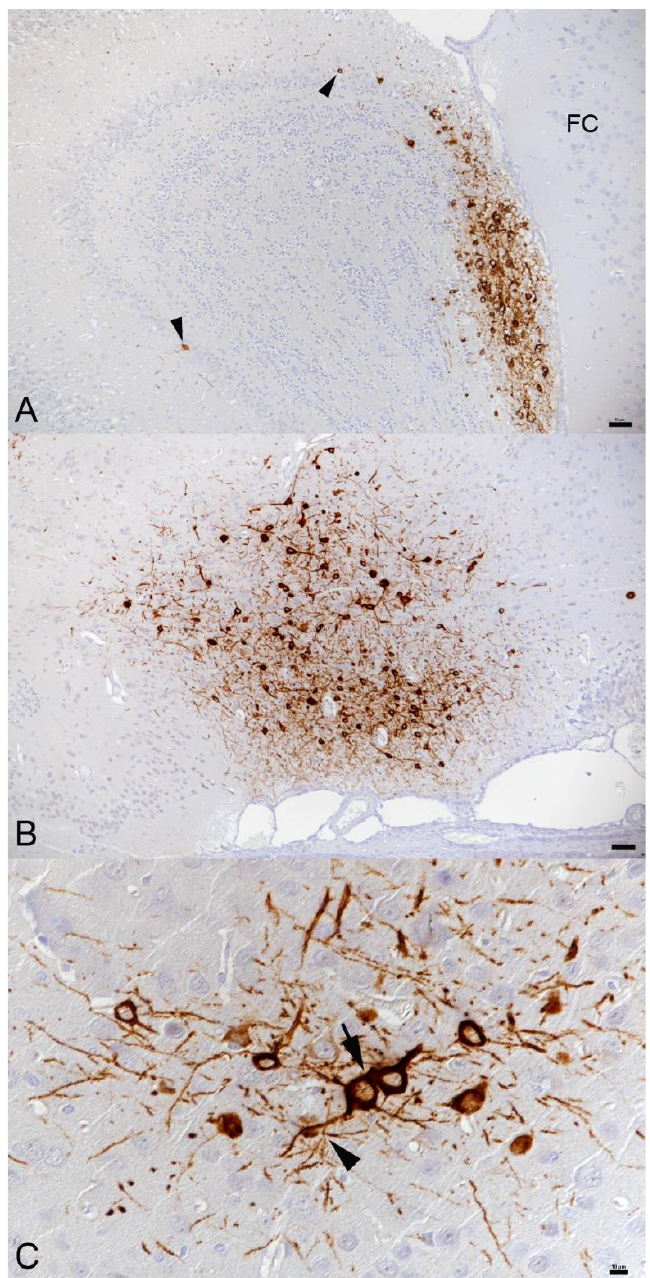
Figure 1. Brain, K18-hACE mice, day 3 post-intranasal infection with SARS-CoV-2 Beta variant at 10 3 PFU. ( A ) Olfactory bulb. Viral antigen is detected in a large patch of neurons in granule layer, inner and outer plexiform layer, mitral layer and glomerular layer and scattered individual neurons. FC — frontal cortex. Bar = 50 µm. ( B ) Brain stem (anterior olfactory nucleus). Large patch of positive neurons. Bar = 50 µm. ( C ) Cortex, same animal as in B. Patch of positive neurons with viral antigen expression in both cell body and processes. Neurons (arrow) and neuronal processes (arrowhead) often appear close apposed. Bar = 10 µm. Immunohistochemistry, hematoxylin counterstain. At days 5, 6 and 7 post-infection, the respiratory and olfactory epithelium of the nasal mucosa still exhibited viral antigen expression, more extensive in the Pango lineage B, Alpha, Beta and Delta variant than in Omicron infected mice, as confirmed by differences in viral loads detected in throat swabs [49], and decreasing with time. Infected cells gen- erally appeared unaltered. At day 5 (studied in Delta and Omicron infected mice), the lungs of the Delta variant infected mice exhibited a mild to moderate multifocal to diffuse